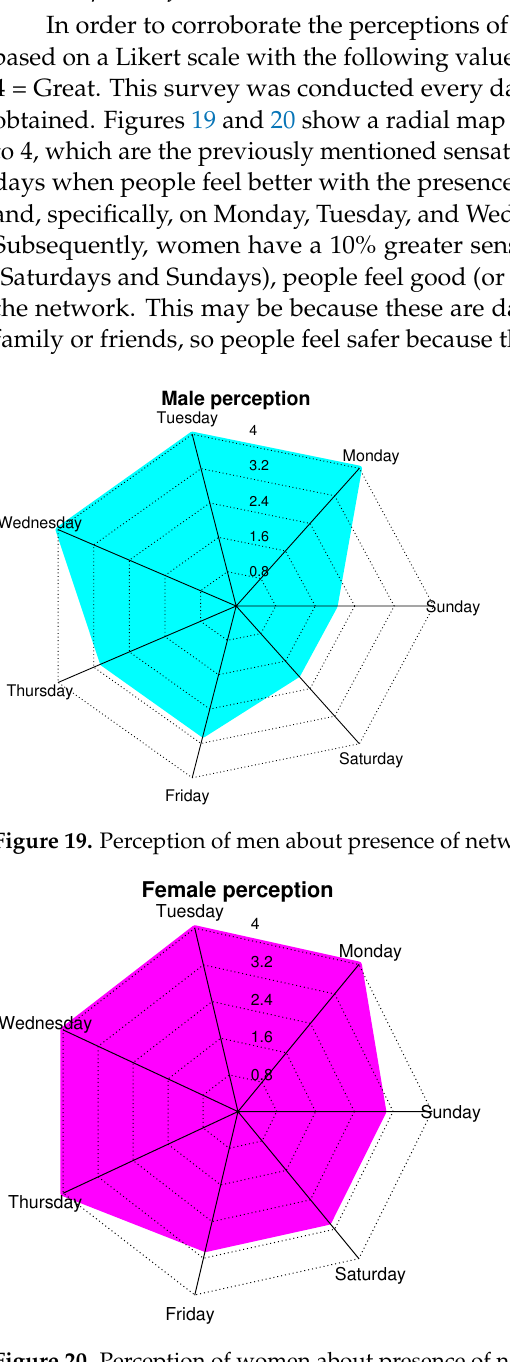
Figure 20. Perception of women about presence of network according to days of